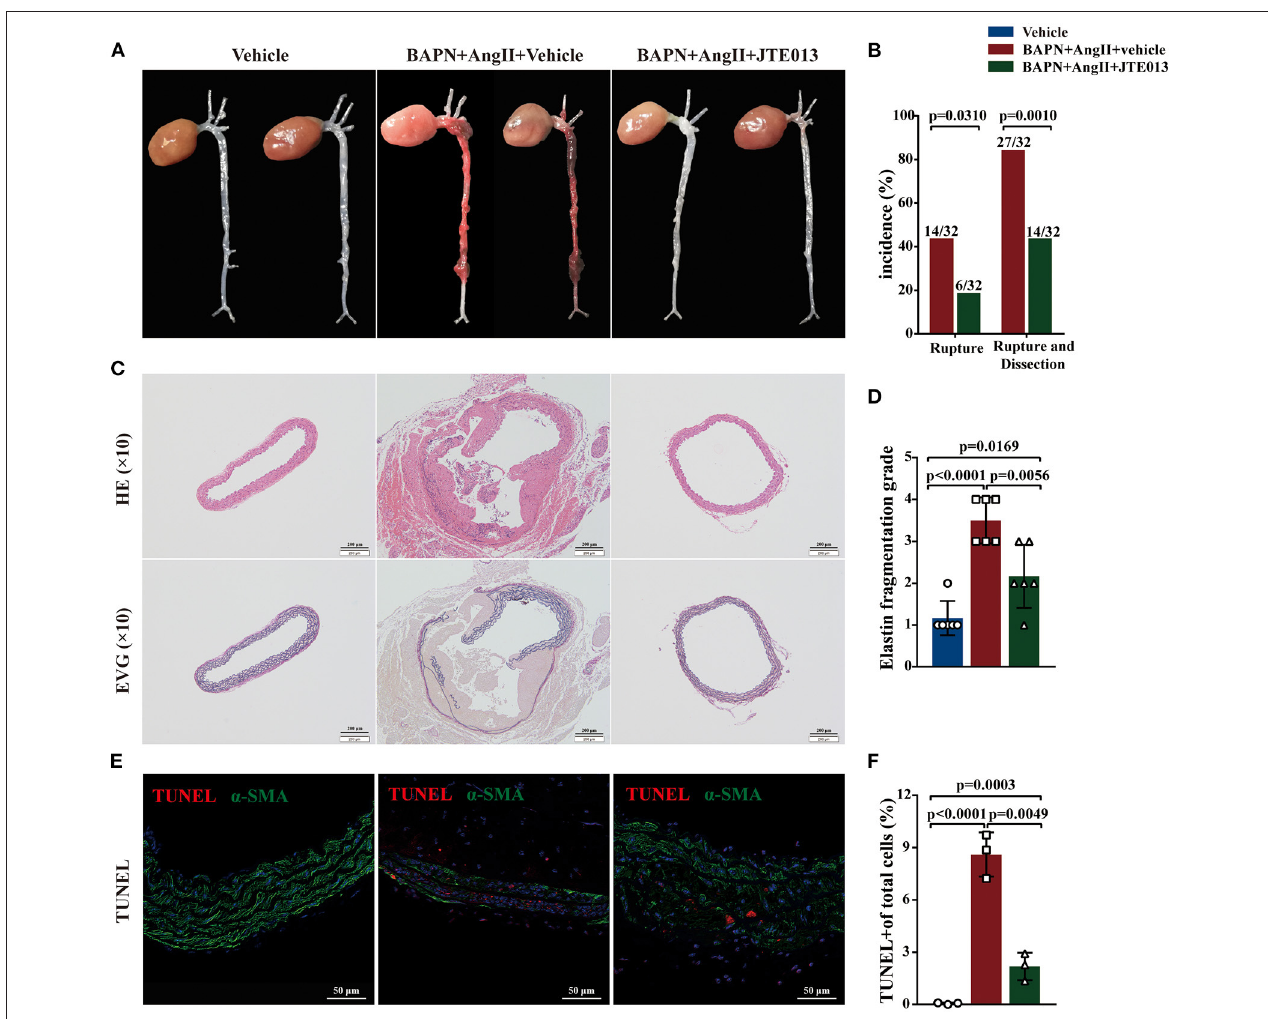
FIGURE 3 | Inhibition of S1PR2 by JTE013 blunted acute aortic dissection (AAD) formation and prevent aortic rupture. (A) Representative morphology of the aortas in each group. (B) The JTE013 treatment attenuated AAD formation and prevent aortic rupture. (C) Representative images of hematoxylin and eosin staining and elastin-van gieson elastin staining of aorta lesions. (D) Elastic fiber fragmentation grade analysis ( n = 6). (E) Representative images of Terminal deoxynucleotidyl transferase dUTP nick-end labeling (TUNEL) (red) and α -SMA (green) double-immunofluorescence staining area. (F) JTE013 treatment resulted in a restraint of SMCs apoptosis level ( n = 3). Scale: 200 µ m or 50 µ m. Data are expressed as means ±